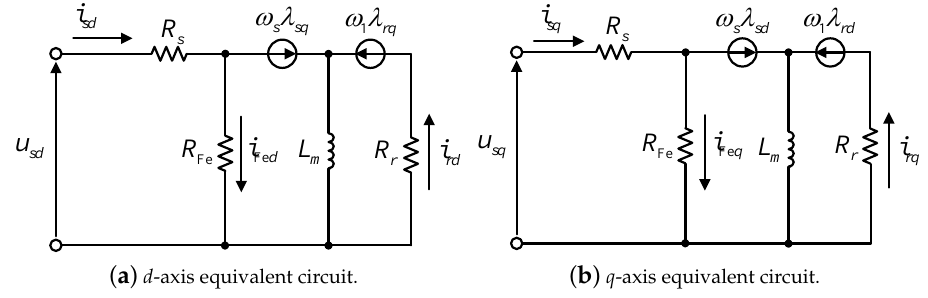
Figure 2. Equivalent circuit of